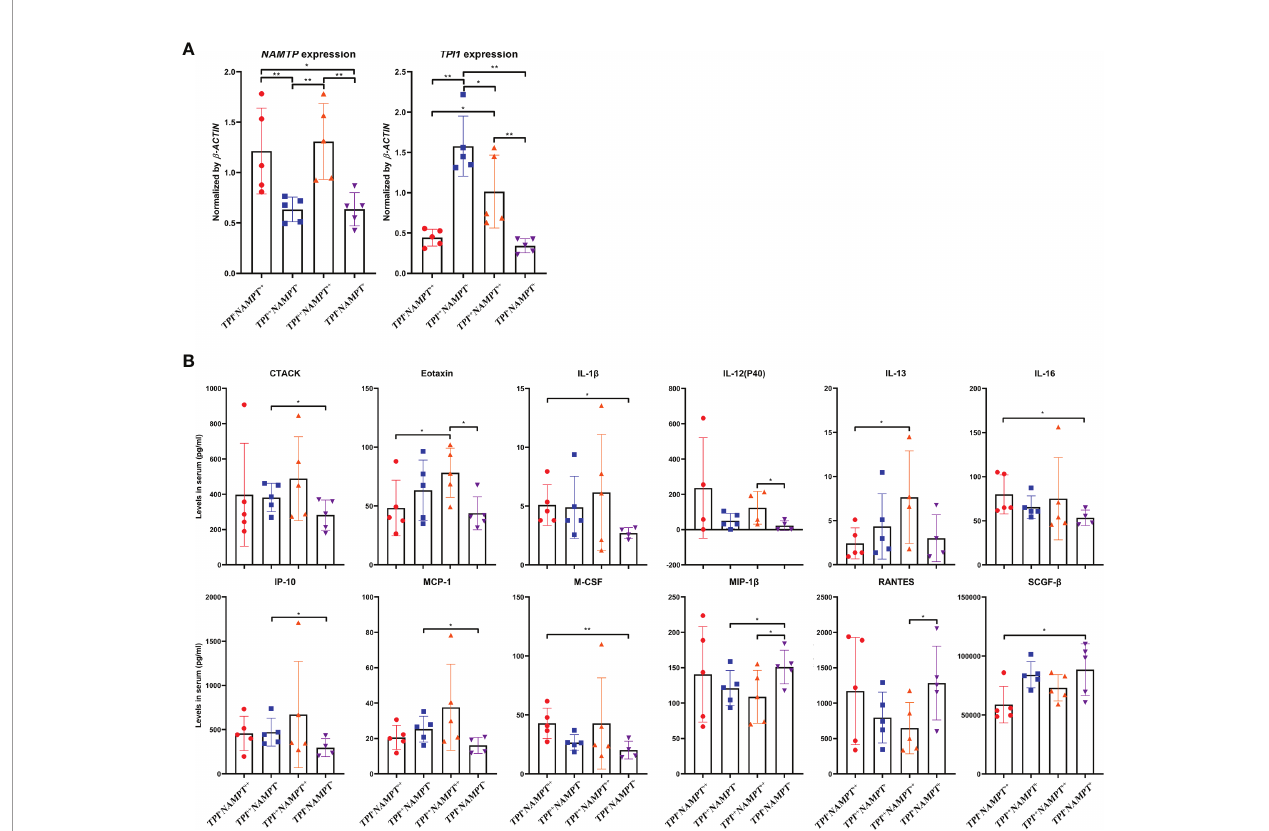
FIGURE 7 | Impacts of NAMPT and TPI1 expression on cytokine pro fi le in RA patients. (A) grouping strategy and mRNA expression levels of NAMPT and TPI1 in different RA subgroups; (B) levels of cytokines with signi fi cant concentration differences among subgroups. The statistical signi fi cance p values < 0.05* or 0.01** were calculated between groups matched by